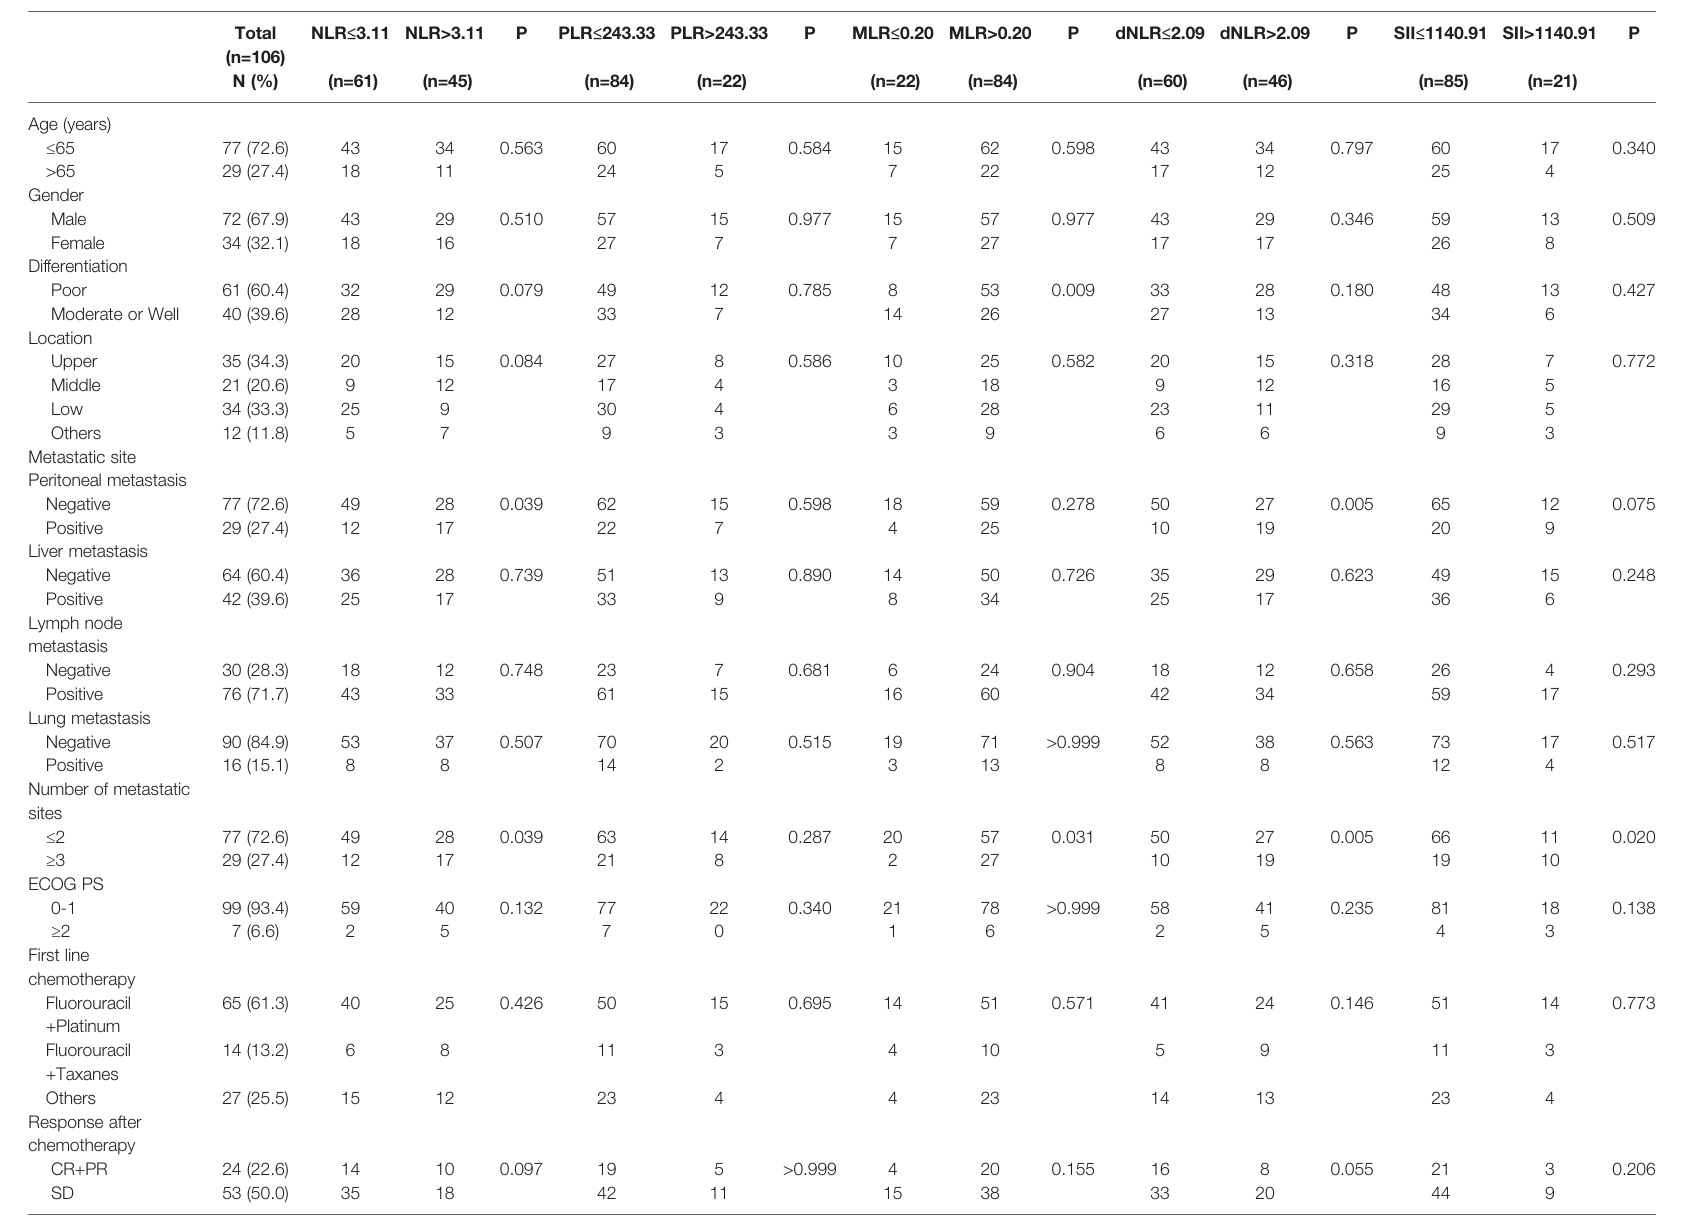
TABLE 1 | Baseline clinical characteristics of AGC